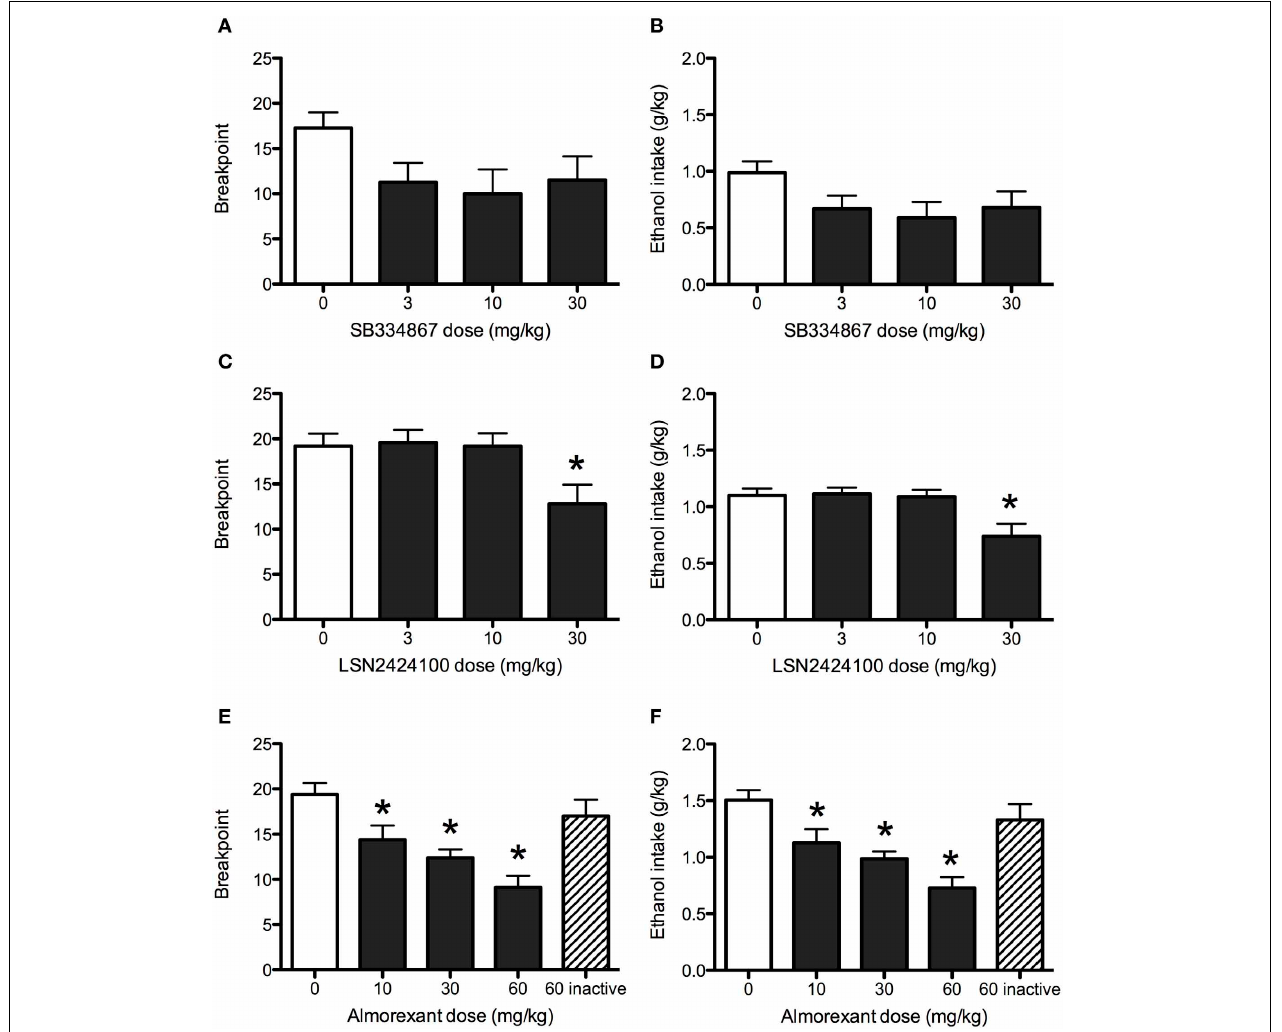
FIGURE 2 | Operant progressive ratio responding in P rats. SB334867 ( n = 8) did not significantly reduce breakpoints (A) or ethanol consumption (B) maintained by a progressive ratio operant schedule of reinforcement. The 30mg/kg dose of LSN2424100 ( n = 10) reduced the motivation to consume ethanol as indicated by reductions in breakpoints (C) and corresponding ethanol consumption (D) . (E,F) Almorexant ( n = 10) reduced breakpoints and